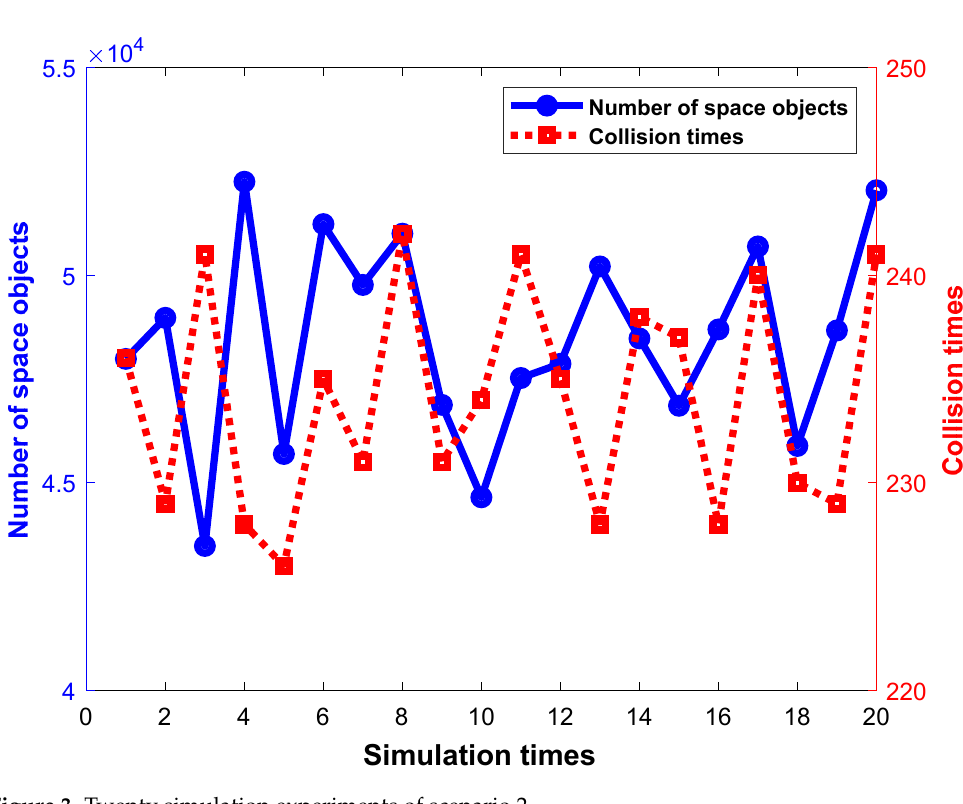
Figure 3. Twenty simulation experiments of scenario 2.